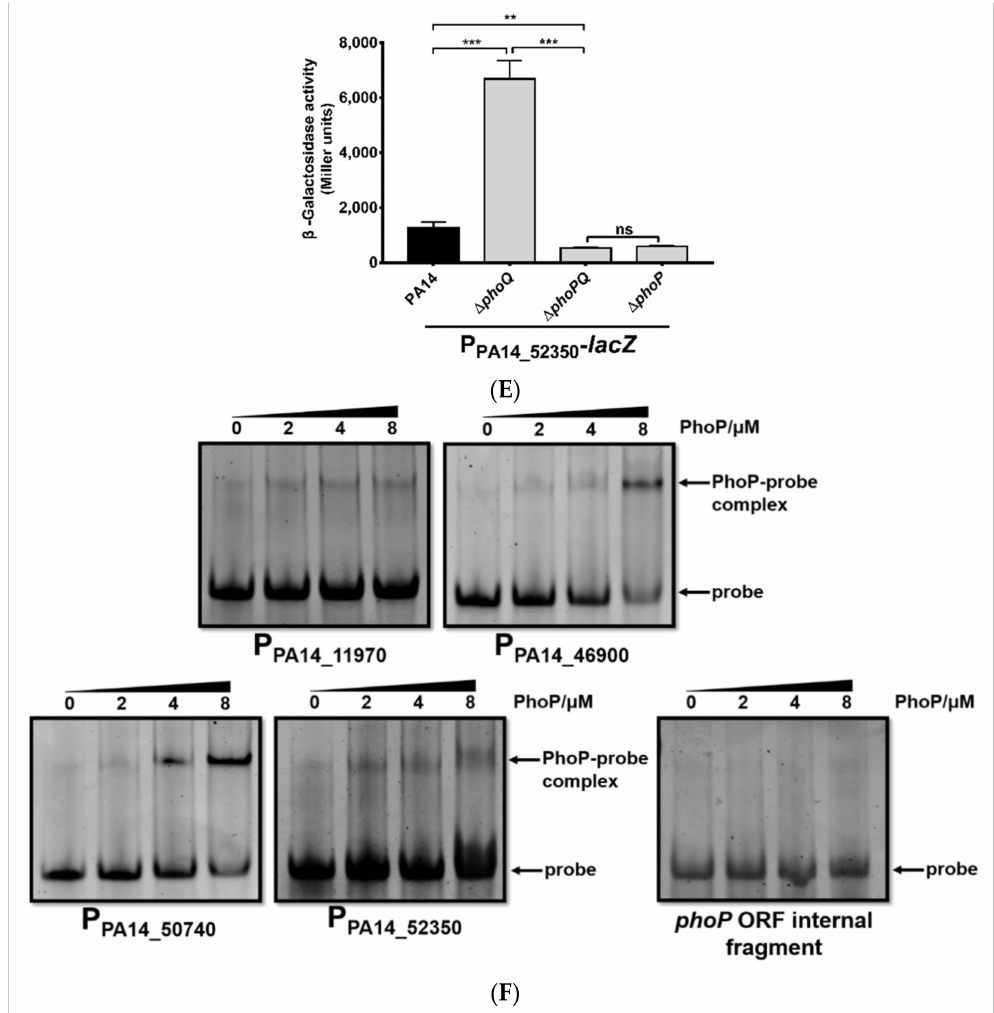
Figure 2. Promoters regulated by the PhoP-PhoQ two-component regulatory system. The transcriptional fusions of P PA14_11970 - lacZ ( A ), P PA14_46900 - lacZ ( B ), P PA14_50740 - lacZ ( C ), P PA14_52340 - lacZ ( D ), and P PA14_52350 - lacZ ( E ) were transferred into PA14 and the phoP , phoQ , and phoP-phoQ mutants. The bacteria were cultured in LB at 37 ◦ C to an OD 600 of 1.0. The values (Miller units) are the means of three experiments. ns, not significant. **, p < 0.01; ***, p < 0.001, by Student’s t -test. ( F ) Interactions between PhoP and its target DNAs were examined by EMSA. Purified 6 × His-tagged PhoP was incubated with the promoter regions of the indicated genes (see Table S2). The internal fragment within the phoP coding region was used as a negative control. Arrows indicate the positions of unbound probe and PhoP-probe